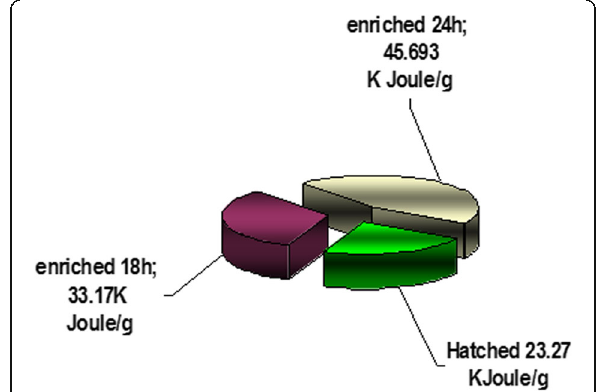
Fig. 7 Ascorbic acid concentrations ( μ g/g dry weight) in unenrichment and enrichment (24 h) Artemia tunisiana